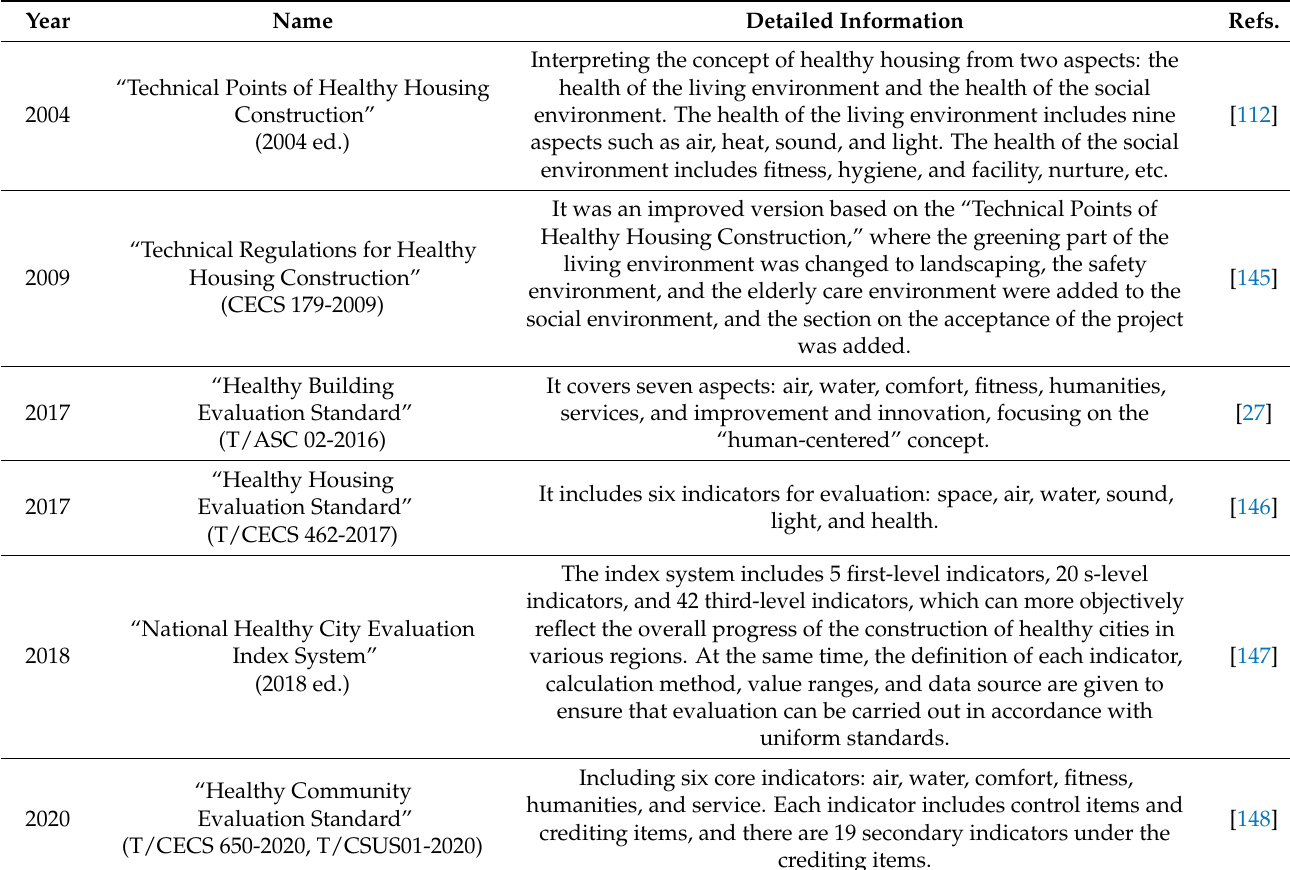
Table 6. Healthy building standards and guidelines in China.